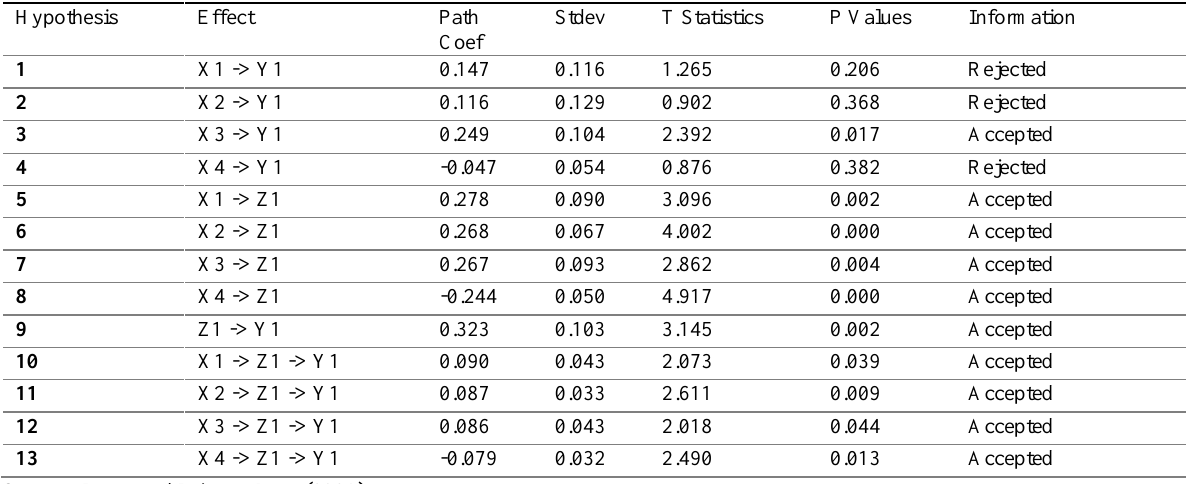
Table 5: Hypothesis Testing